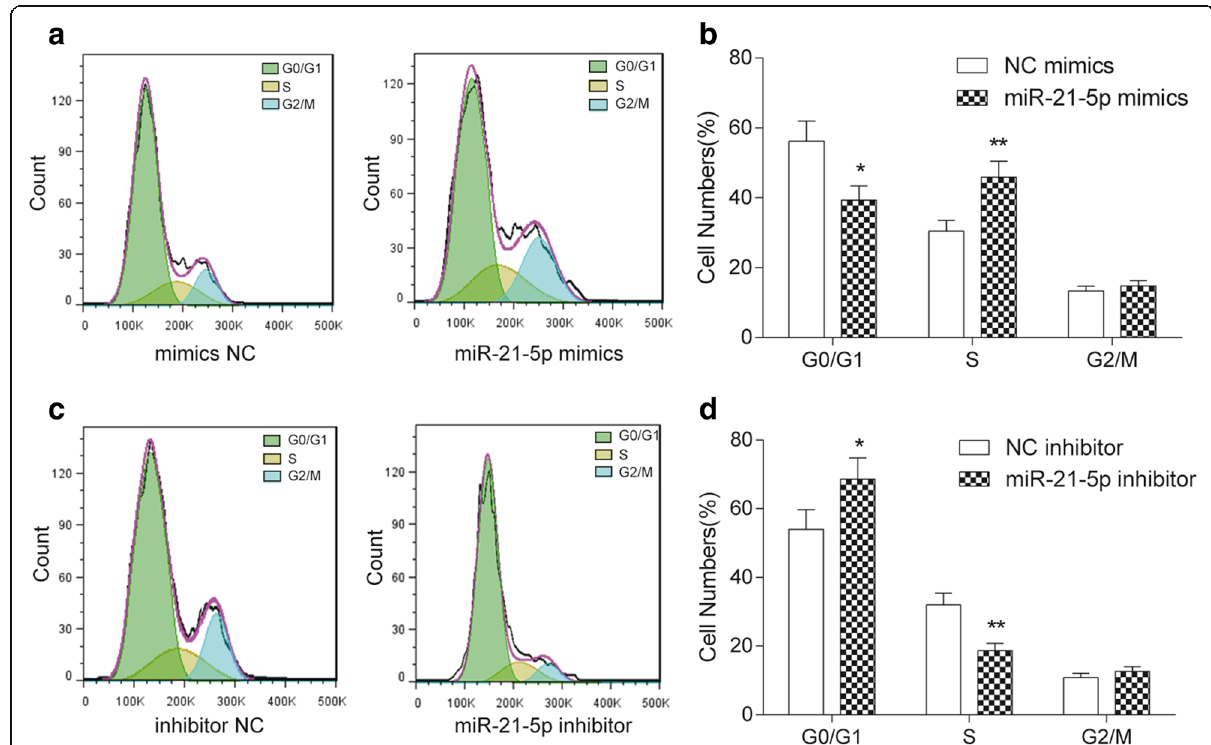
Fig. 4 MiR-21-5p promoted the cell cycle of COAD cells. a , b Compared with NC mimics, more cells in miR-21-5p mimics group were arrested in S phase and less cells appeared in G0/G1 phase. * P < 0.05, ** P < 0.01, compared with NC mimics group. c , d Compared with NC inhibitor, more cells appeared in G0/G1 phase and less cells were arrested in S phase. * P < 0.05, ** P < 0.01, compared with NC inhibitor